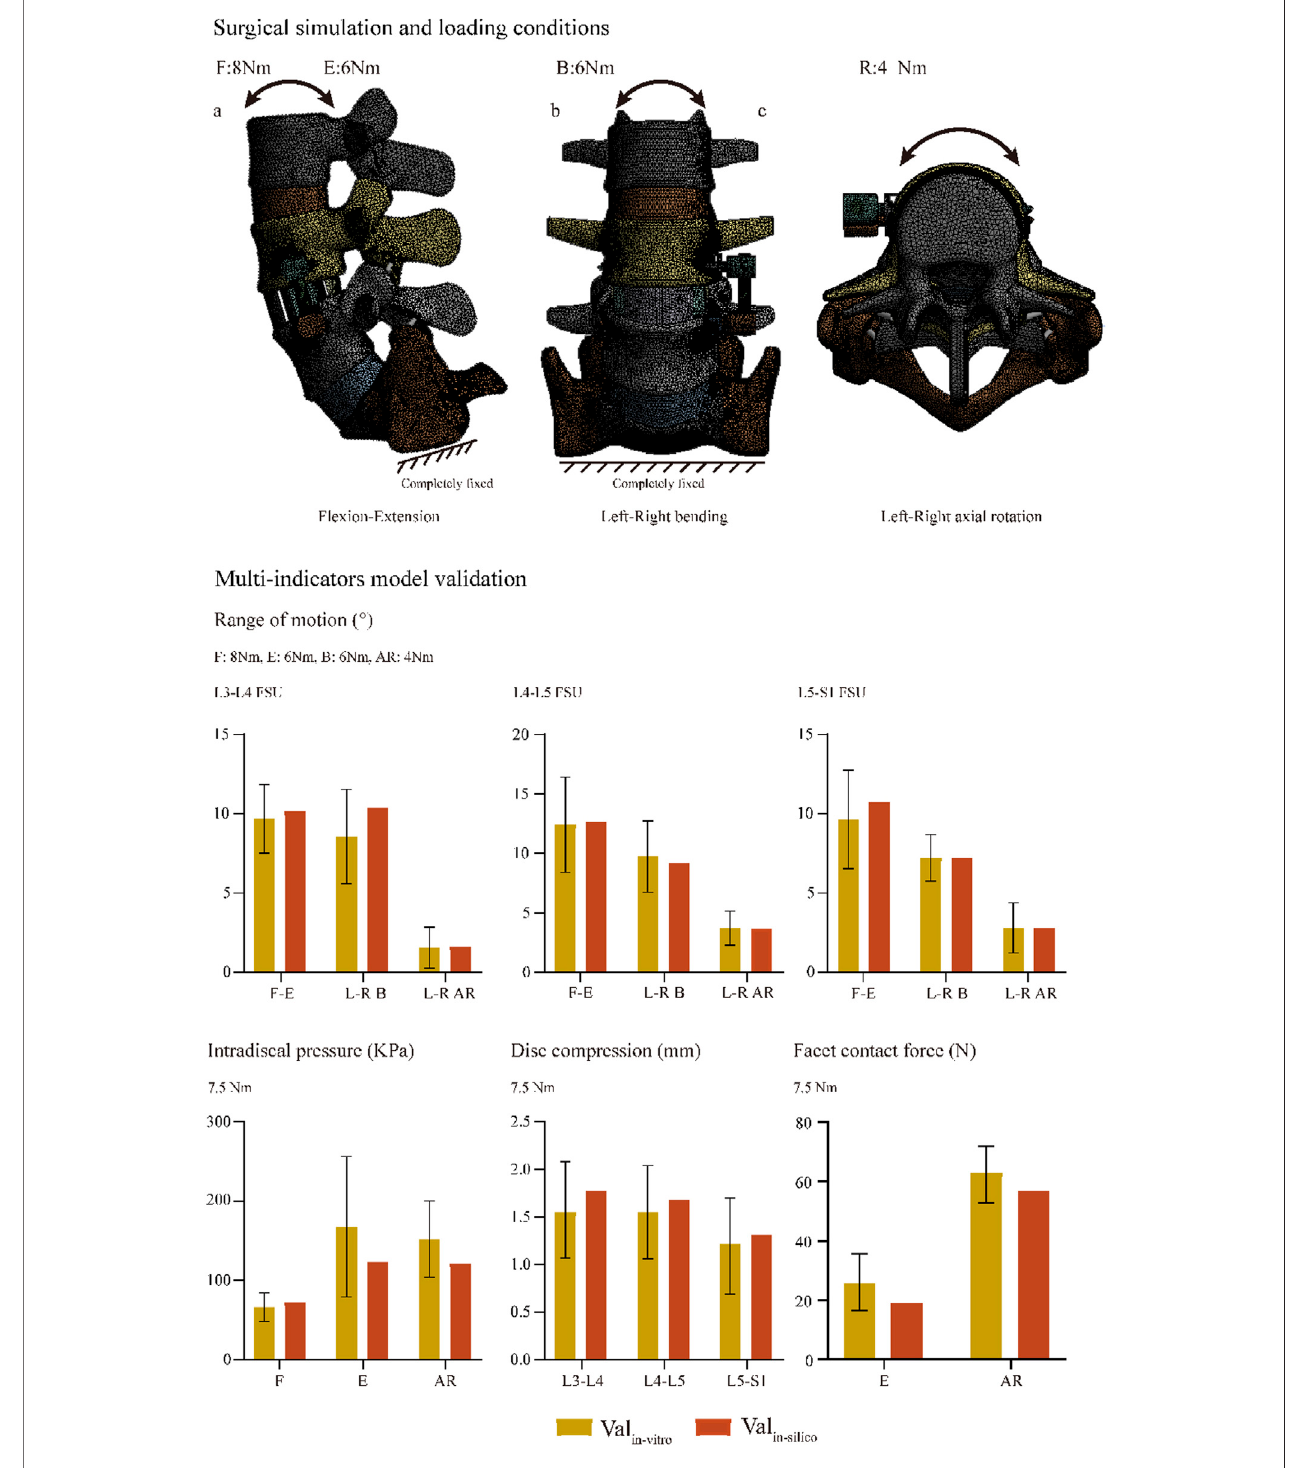
FIGURE 3 | Surgical simulations and multi-indicator model